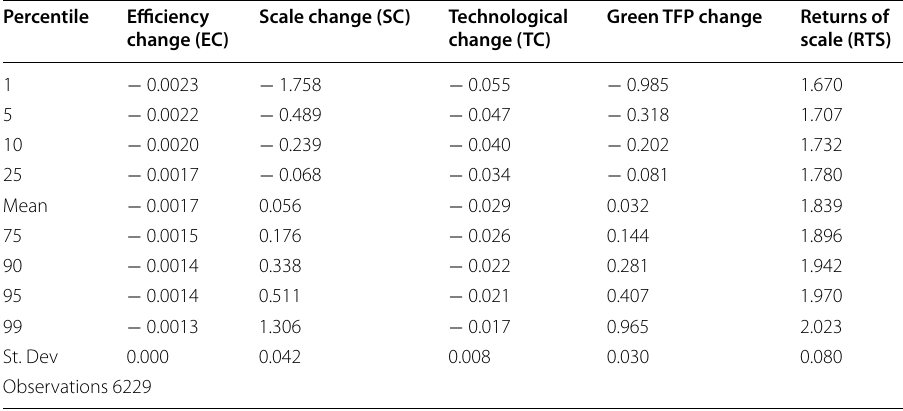
Table 3 Yearly GTFP and its components in